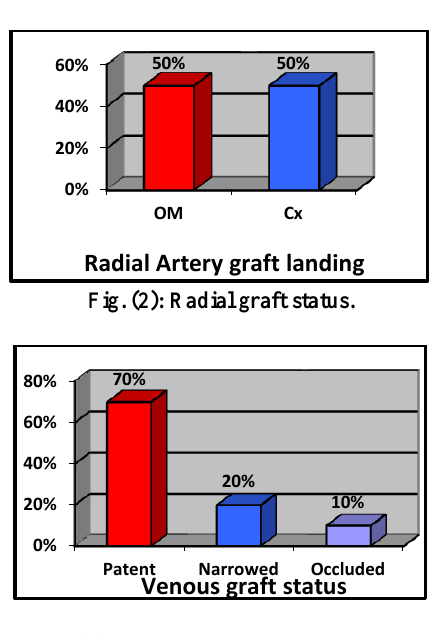
Fig. (3): The status of venous grafts.